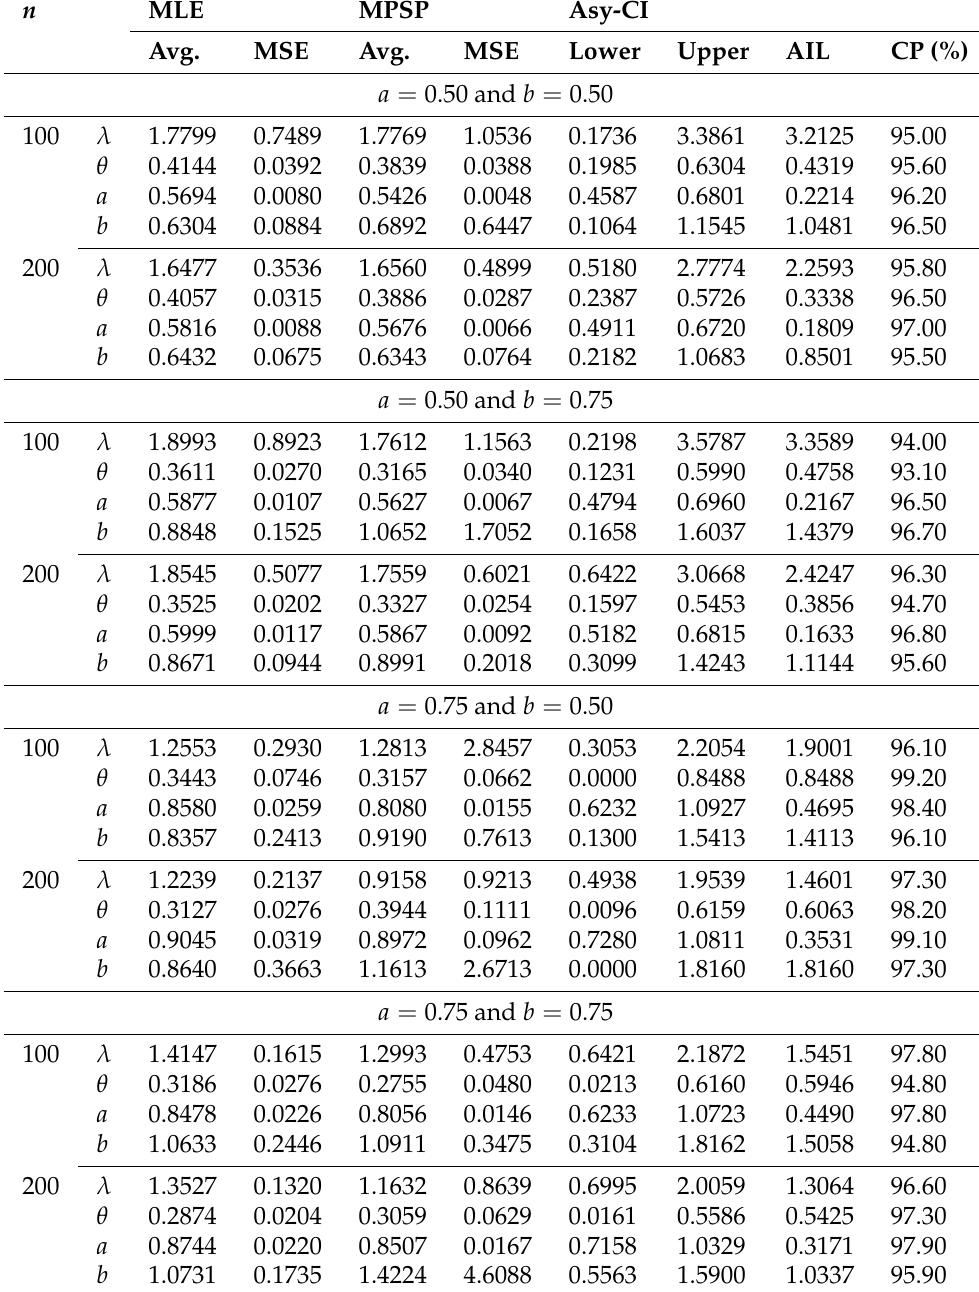
Table 7. Avg. estimated values, MSEs, Asy-CI, AILs and CP (in %) of Non-BE (MLE and MPSP) for the BBE 2 distribution at different sample sizes n and different values of ( a , b ) when λ = 1.50, θ =